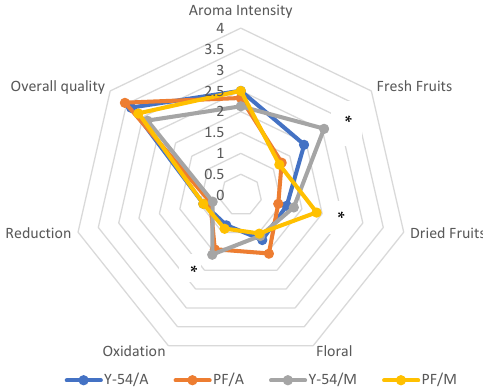
Figure 8. Sensory data of wine samples. Y-54/A: Assyrtiko wine made with S. cerevisiae LMBF Y-54; Y-54/M: Mavrotragano wine made with S. cerevisiae LMBF Y-54; PF/A: Assyrtiko wine made with S. cerevisiae Passion Fruit; PF/M: Mavrotragano wine made with S. cerevisiae Passion Fruit. *: Significant differences were found only between the values of red and white wine samples.